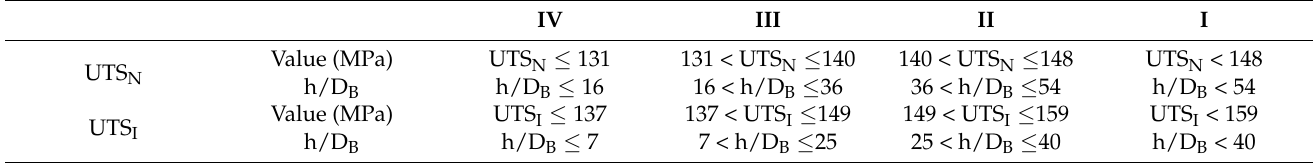
Figure 11. Q–Q diagram of UTS: ( a ) UTS N ; ( b ) UTS I . Table 7. Bamboo tensile strength grading table along the grain.